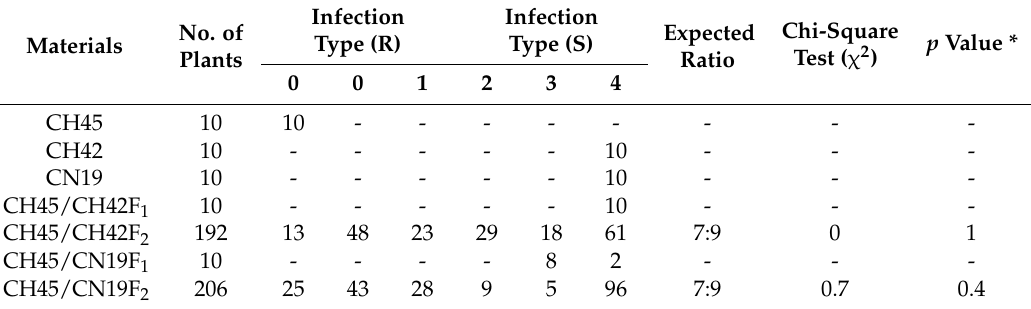
Table 2. Genetic analysis of seedling resistance to stripe rust pathotype No. 09-6-16-3.